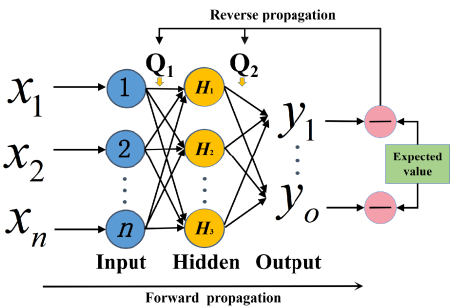
Figure 1. Topology structure and error propagation process of a three-layer BP neural network. The input layer vector is 𝑥 = (𝑥 (𝐻 , 𝐻 , . . . . 𝐻 ) 𝑇 , and the output layer vector is 𝑦 = (𝑦 1 2 𝑚